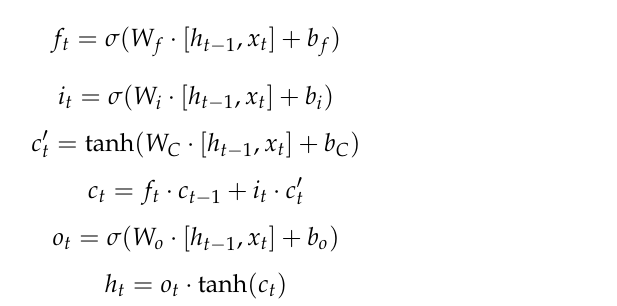
temperature at the target prediction moment, enabling prediction on a time series